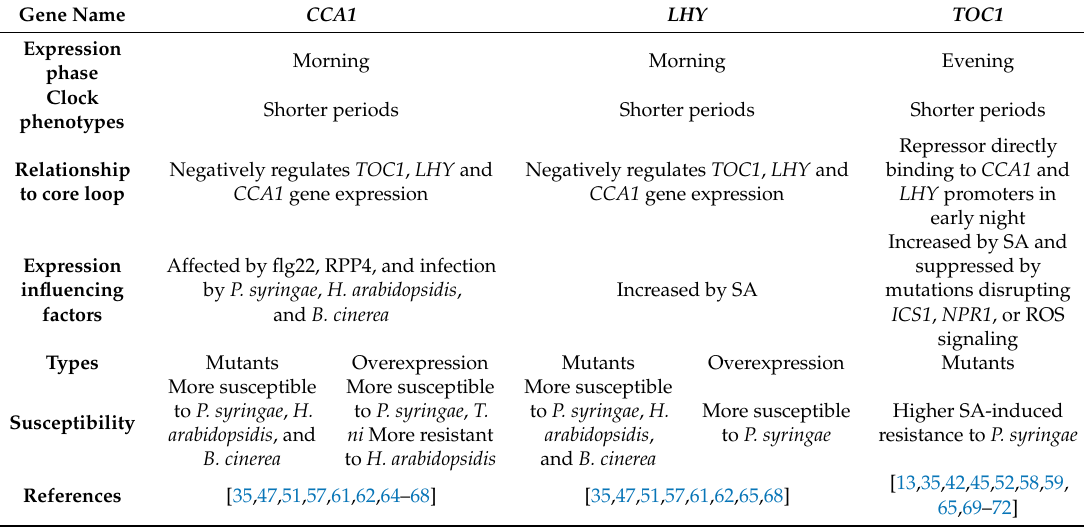
Table 1. Core loop genes are direct regulators of plant